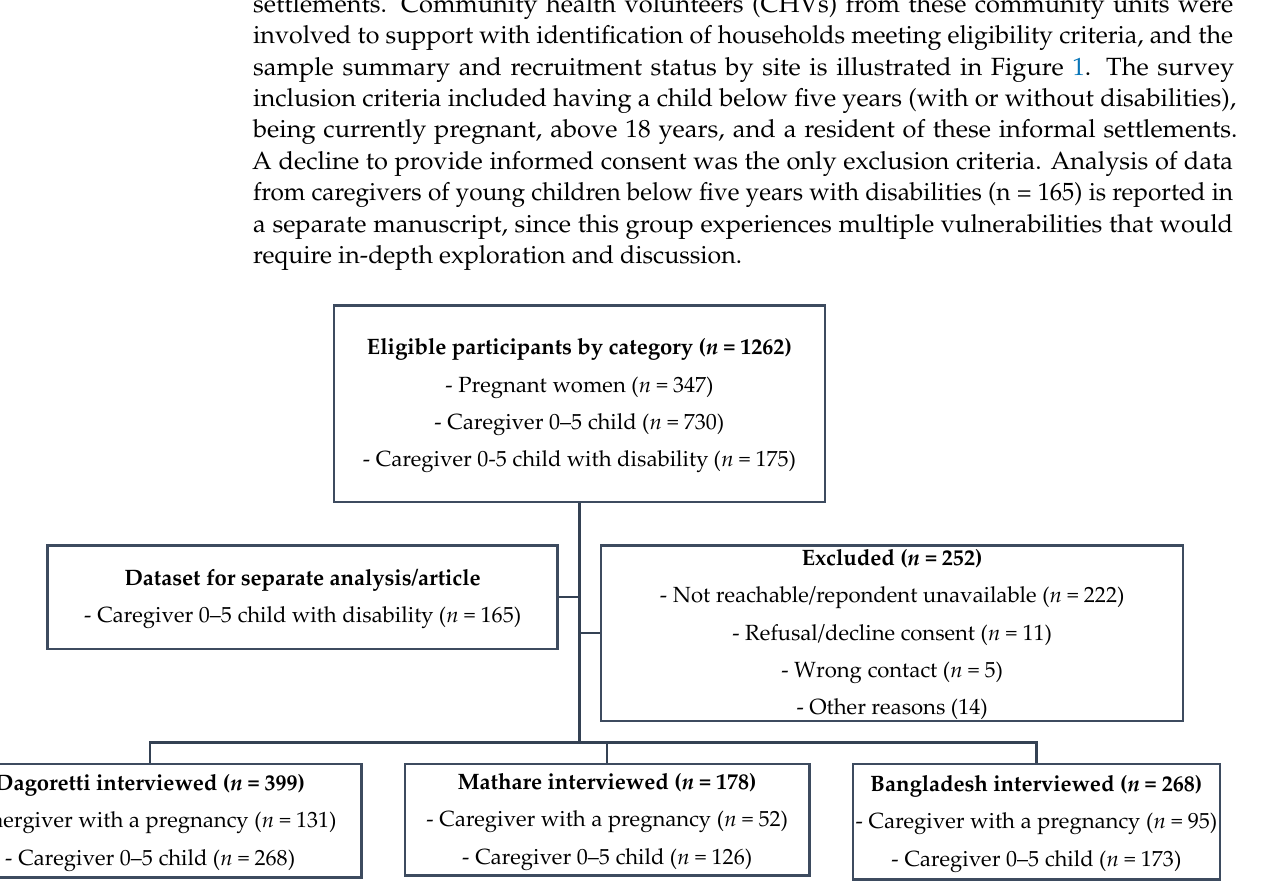
Figure 1. Participants’ recruitment summary.